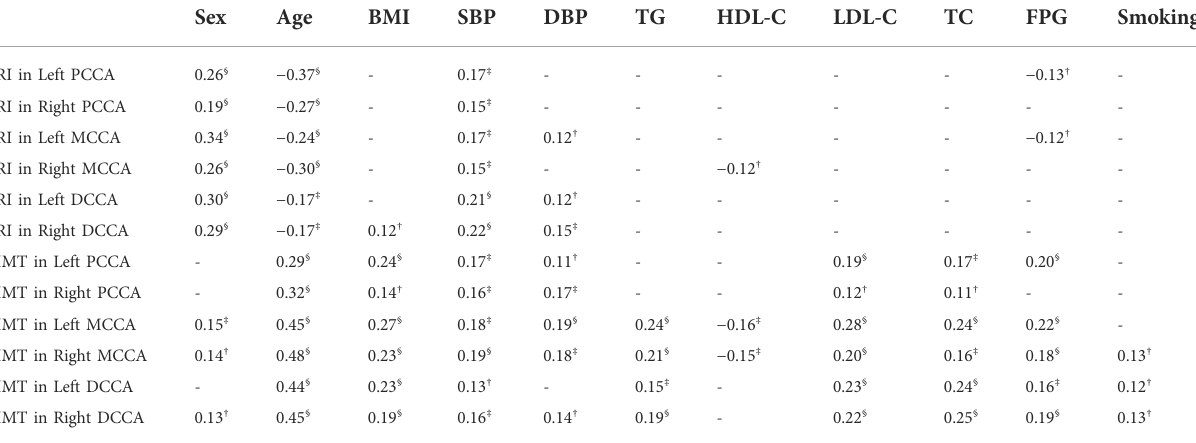
TABLE 3 Spearman correlations between CUS parameters and CVD risk